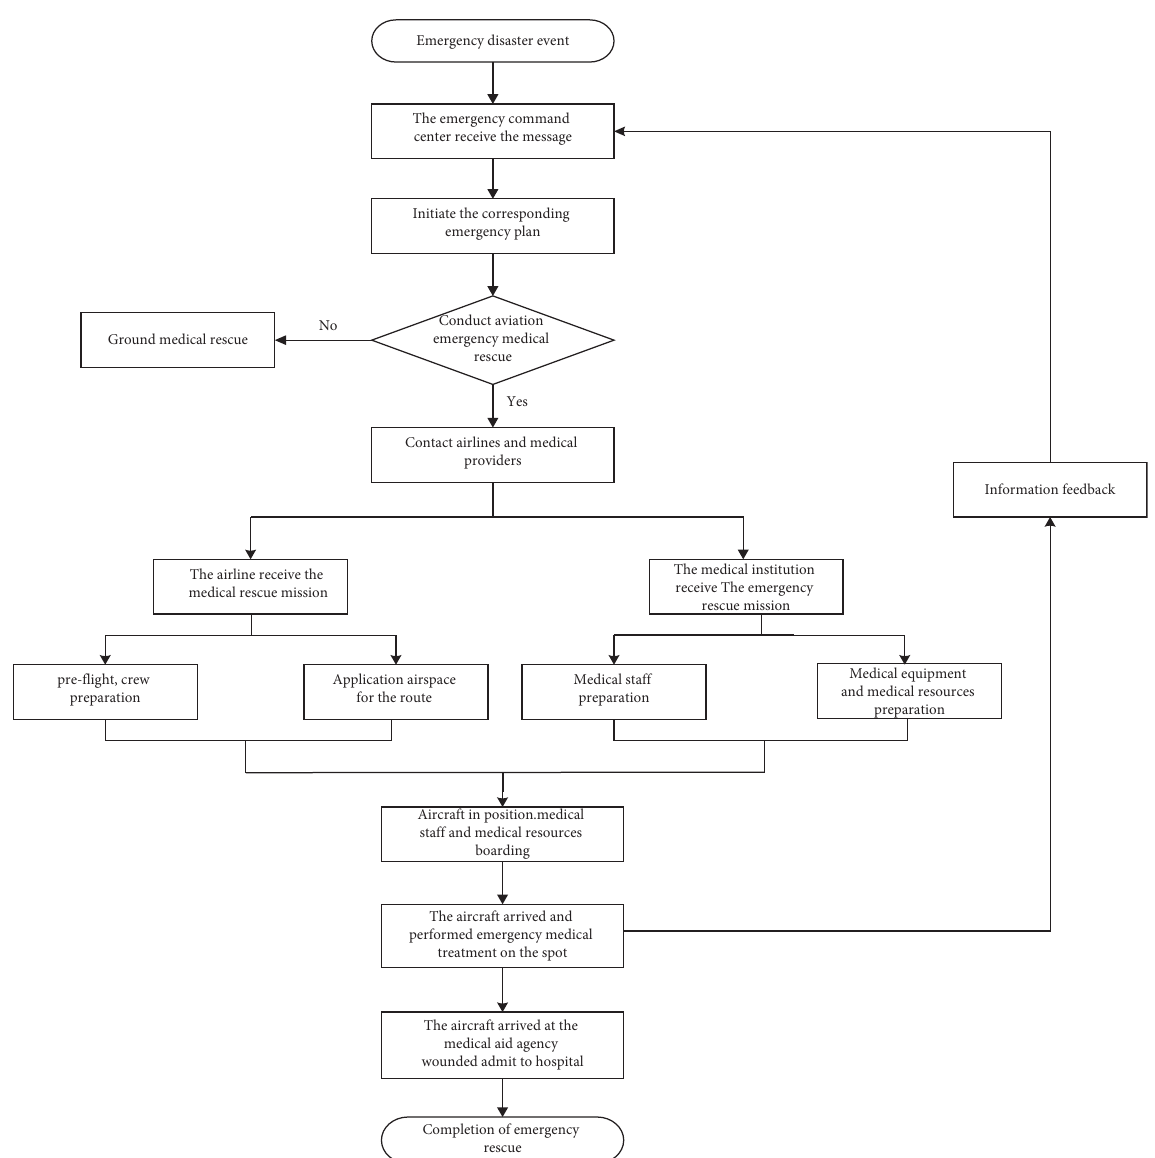
Figure 1: Aviation medical rescue process after